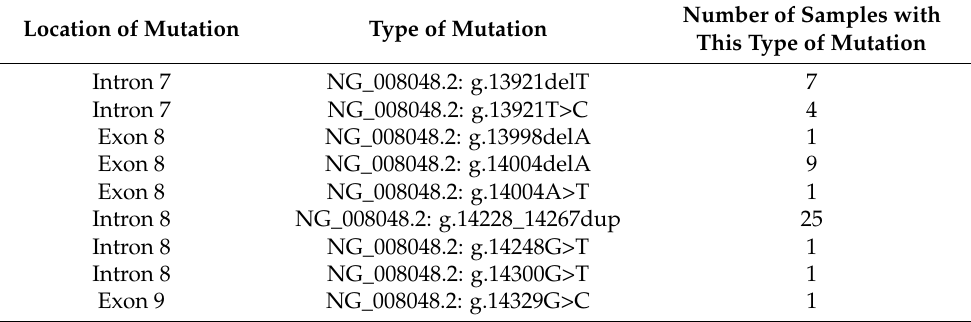
Table 1. Types of mutations detected by Sanger sequencing.